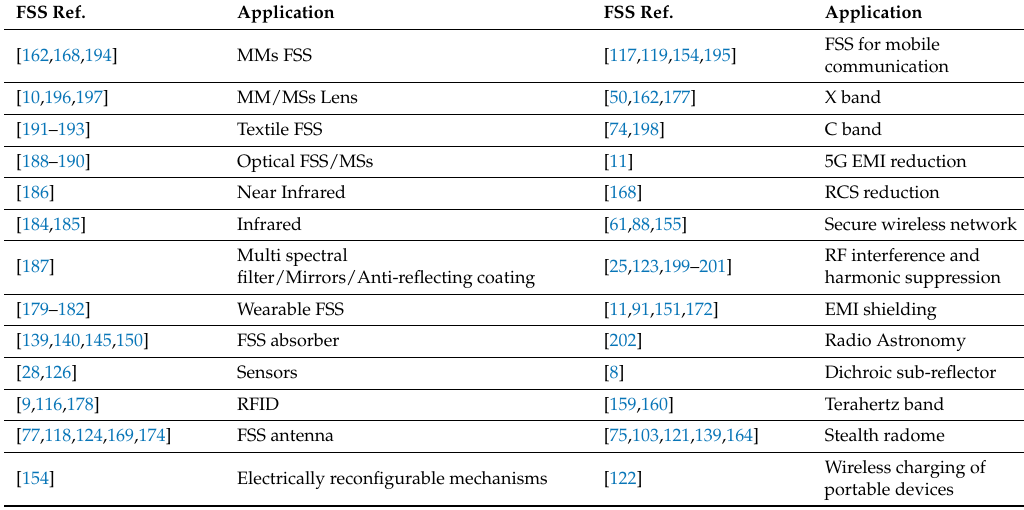
Table 11. Practical applications of